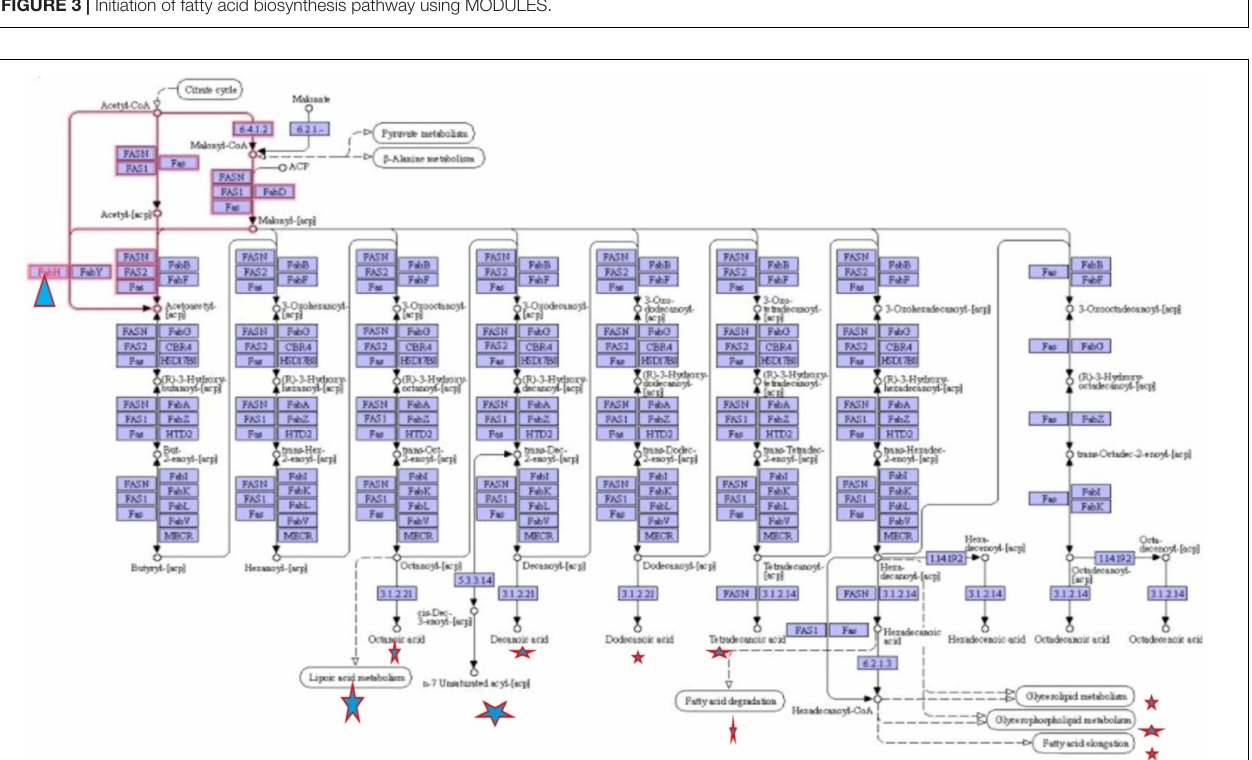
FIGURE 4 | Fatty acid biosynthesis different pathways regulating by FabH.